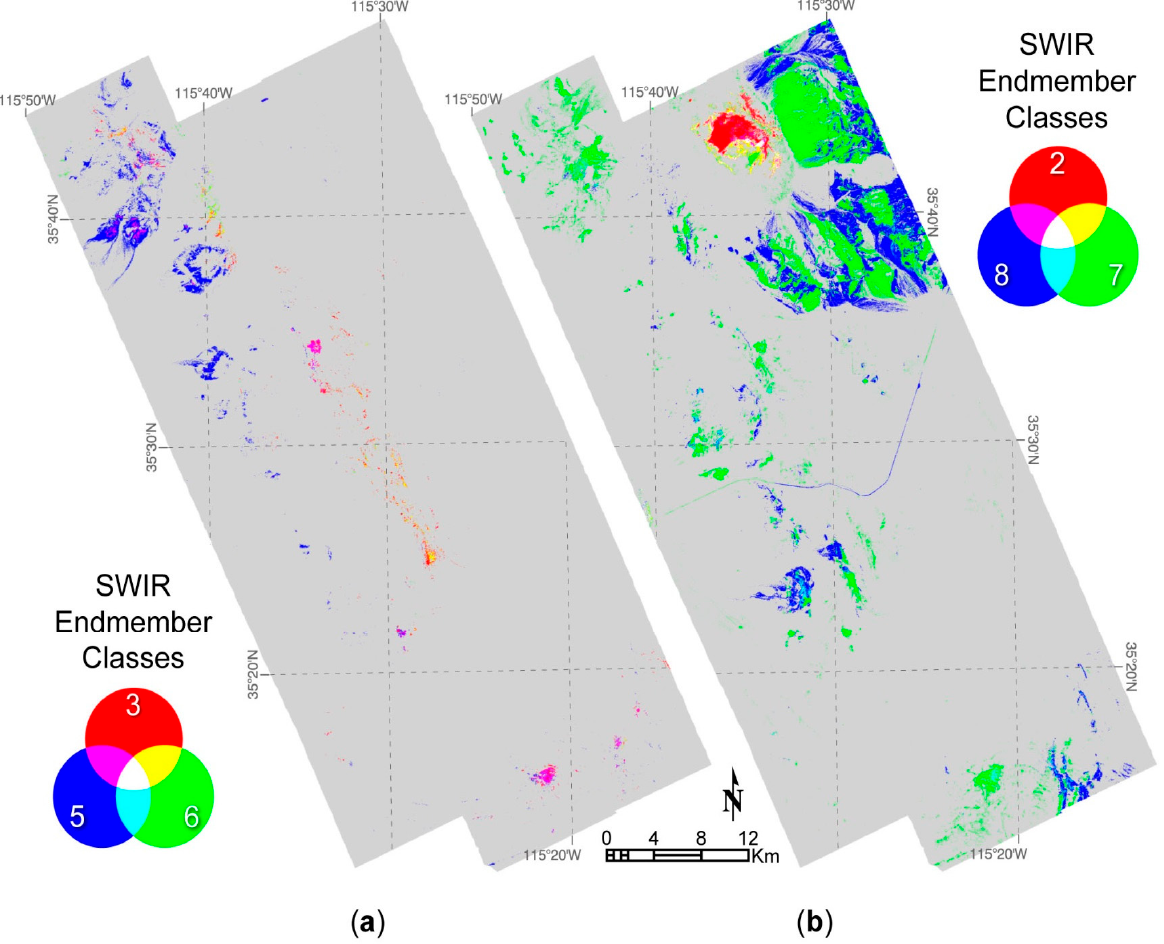
Figure 8. False color composite images of selected shortwave infrared (SWIR) endmember classes: ( a ) 3/6/5 in red/green/blue; ( b ) 2/7/8 in red/green/blue. Pixels with approximate abundance values less than 40% for the selected endmembers are masked in gray.